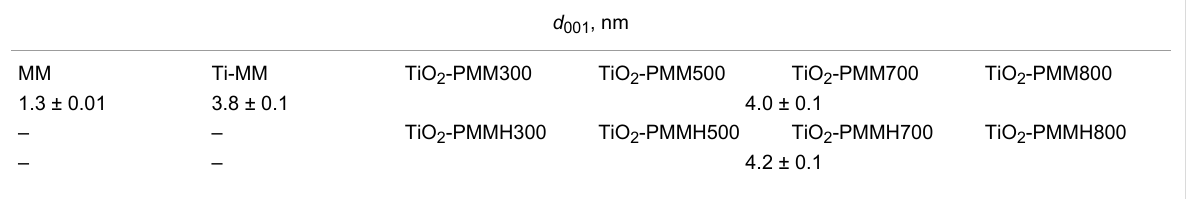
Table 1: Basal distance d 001 of the MM, Ti-MM, TiO 2 -PMM х , and TiO 2 -PMMH х samples (see Experimental section for